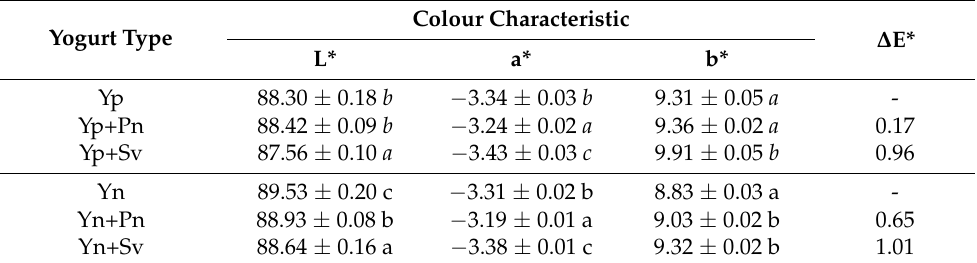
Table 9. The colour characteristic of probiotic (Yp) and natural (Yn) yogurt with or without scCO 2 /H 2 O extracts from P. nigra (Pn) and S. viminalis (Sv) on the first day of storage